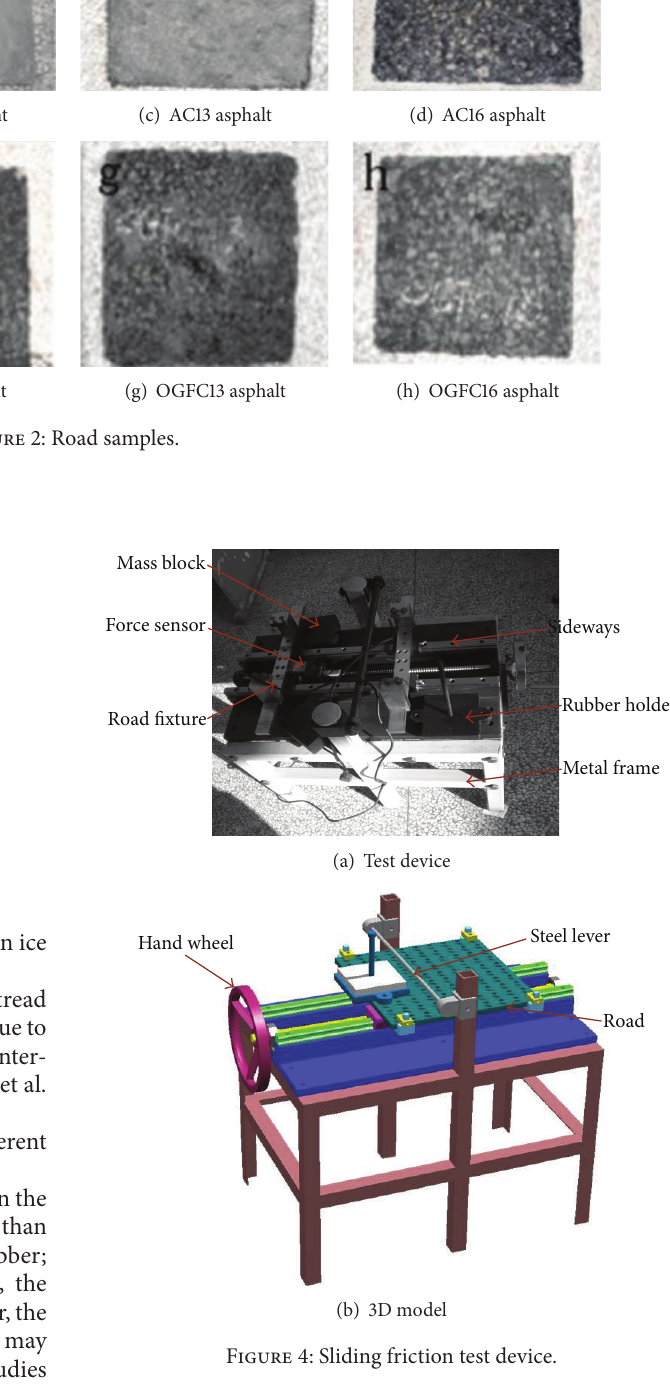
Figure 4: Sliding friction test